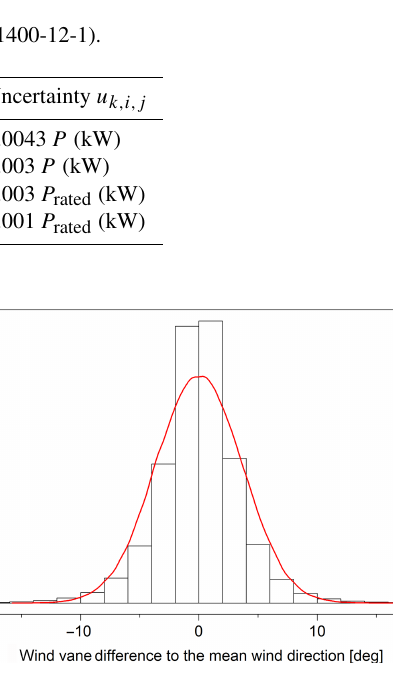
Figure 6. Estimation of the uncertainty of the artificial wind direc- tion. Histogram of the deviation of 30 individual wind vanes from the average wind direction for the full data set filtered for wind speeds > 5ms − 1 with a sector of 30 ◦ centering on the full-wake condition. The red curve represents a Gaussian fit with a standard deviation of 3.6 ◦